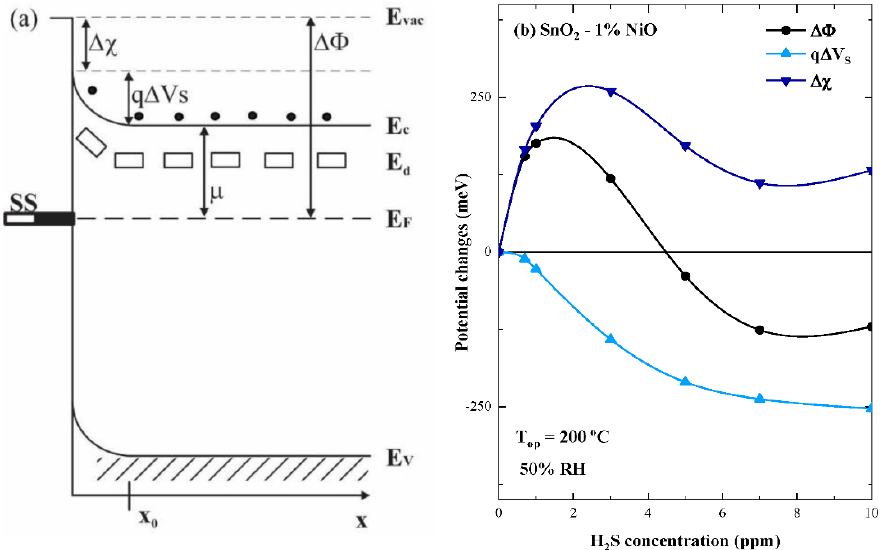
Figure 10. Band energy diagram valid for an n-type SMOX sensitive material ( a ) and experimental surface potential changes for SnO 2 -1%NiO at fixed operating temperature and RH, over a wide range of H 2 S concentrations ( b ).